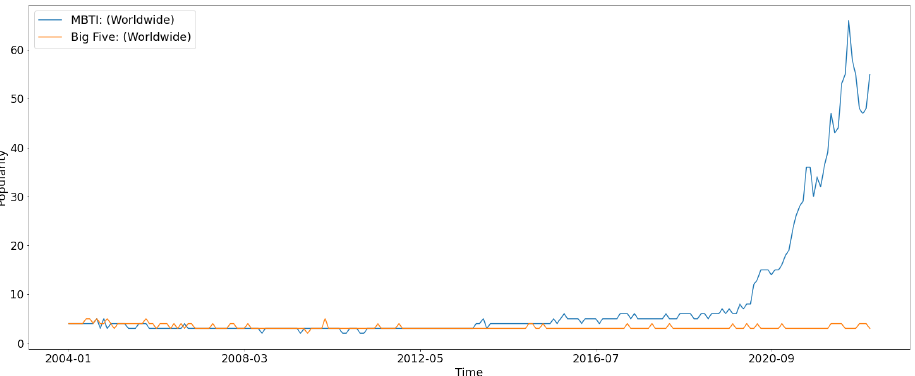
Figure 2. The frequency of personality models appearing as Google search terms, showcasing the interests of the general public. Data source: https://trends.google.com/trends/ (accessed on 28 March